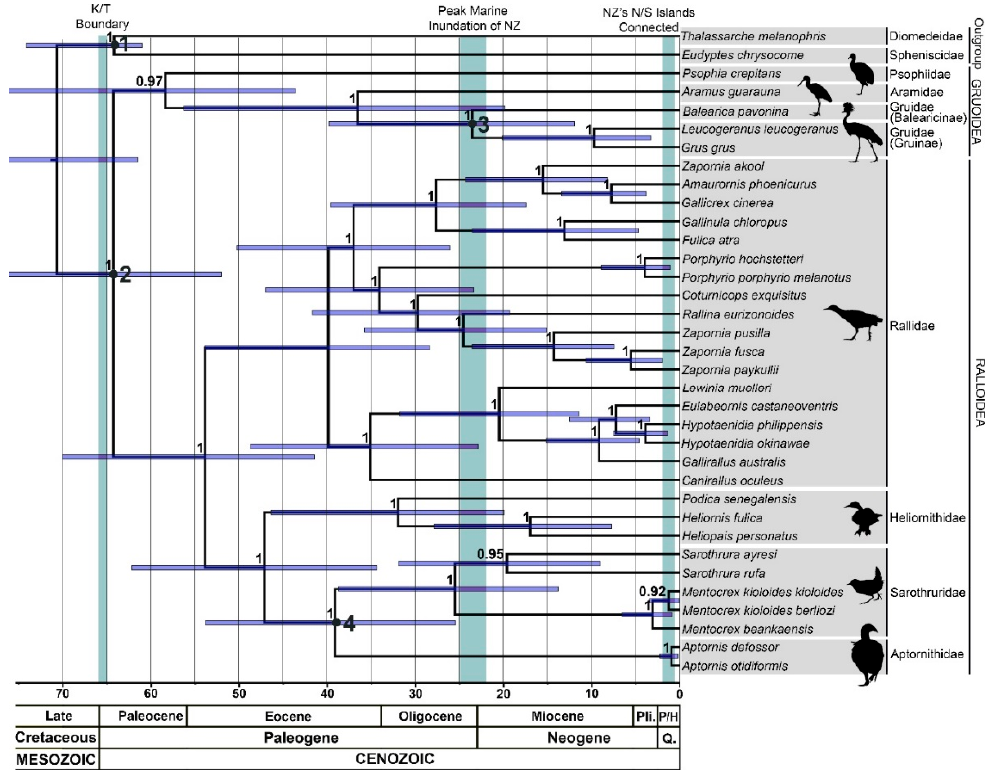
Figure 2. BEAST maximum clade credibility consensus tree of alignment B (predominantly complete or near-complete mitochondrial genomes). Scale represents time in millions of years (Ma) before present. Families/subfamilies and superfamilies designated on right. Error bars represent 95% Highest Posterior Densities (HPDs) for node age estimates. Node numbers represent Bayesian posterior probabilities. Calibrated nodes are numbered accordingly (see Methods section for full details).